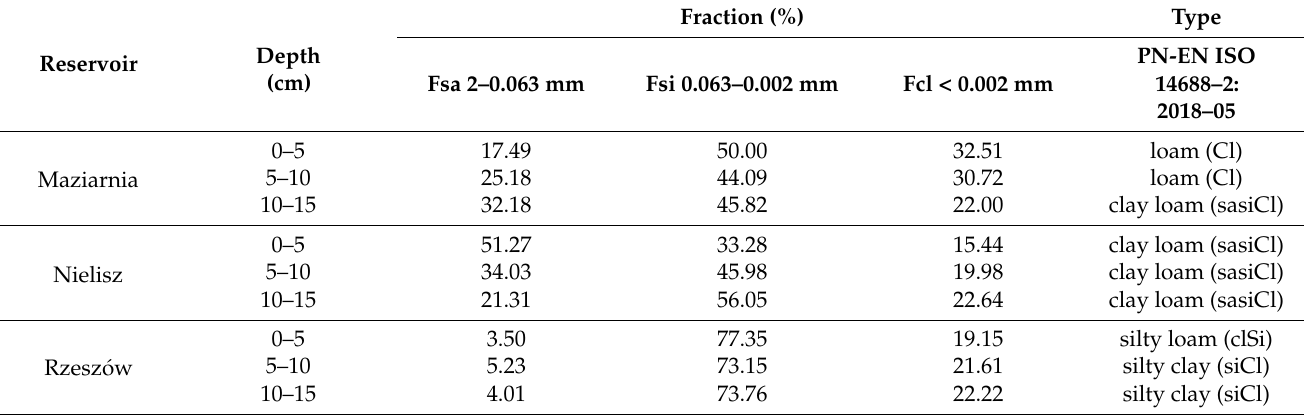
Table 1. Granulometric composition of the studied sediments.